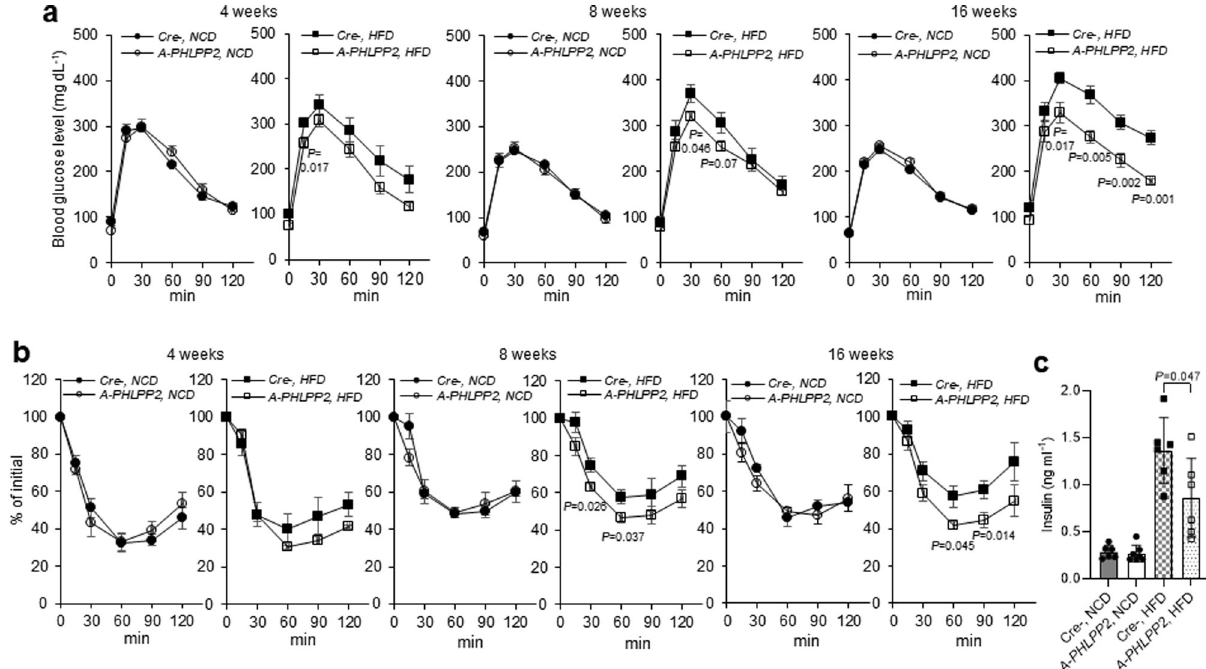
Fig. 2 Adipocyte-speci fi c PHLPP2 ablation improves glucose homeostasis. a Glucose tolerance test (GTT) and ( b ) insulin tolerance test (ITT) with increasing lengths of NCD or HFD feeding in A-PHLPP2 and control mice ( n = 6 – 7 independent mice per group) after tamoxifen injection. c Plasma insulin levels in NCD-fed or HFD-fed A-PHLPP2 and control mice after a 5 h fast ( n = 6 – 7 independent mice per group. All data are shown as the means ± SEM. Statistical signi fi cance was determined by unpaired two-tailed Student ’ s t